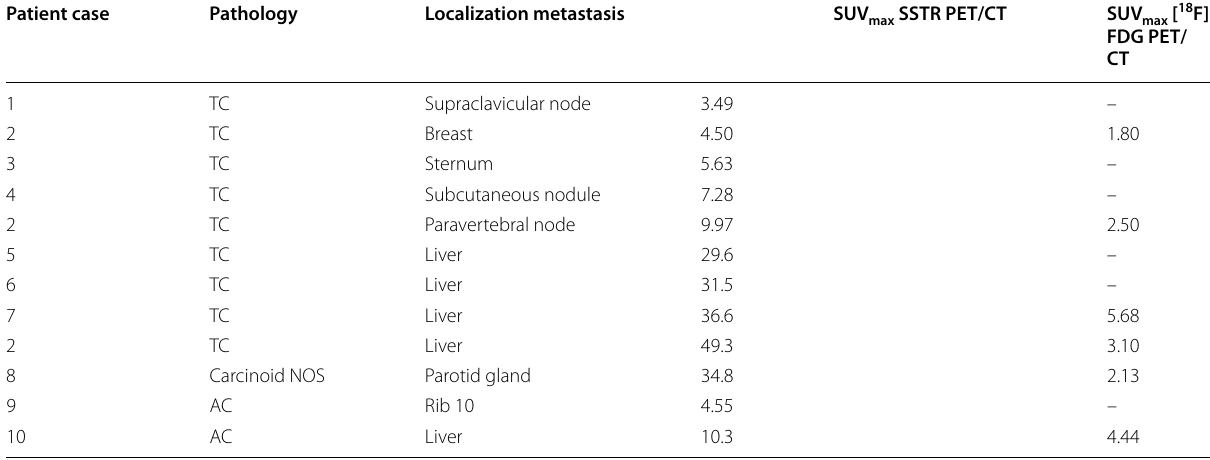
Table 3 All lesions suspicious for metastases on SSTR PET/CT that were pathologically examined were confirmed as metastases of bronchial